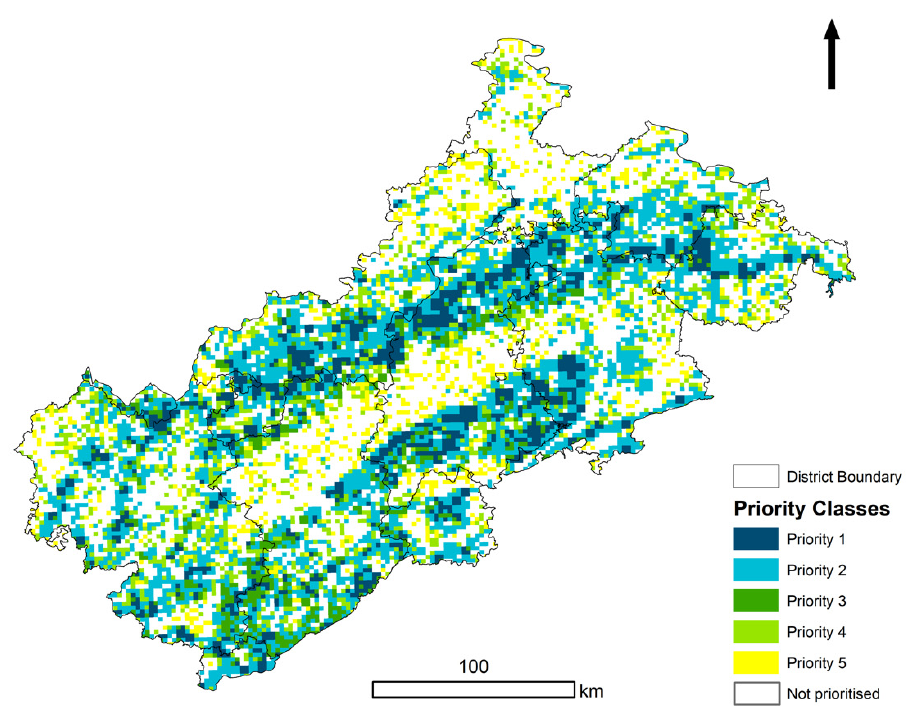
Figure 5. Priority areas for conservation in Panna Landscape.